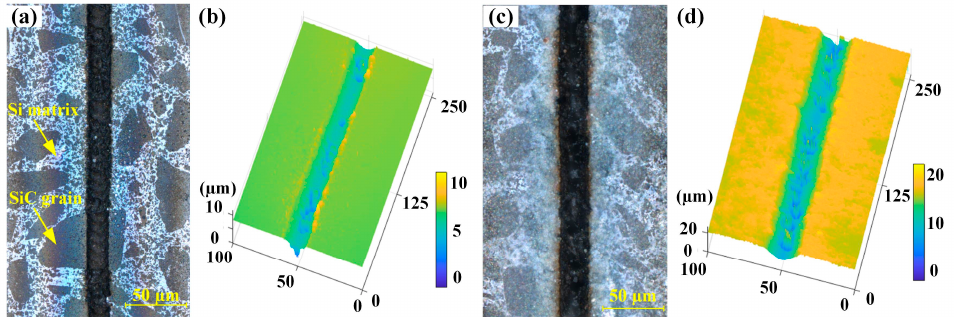
Figure 12. Microgroove morphology with laser energy of 10 µJ and scanning speed of 50 mm/s for the different number of passes: ( a ) 2D image and ( b ) 3D profile of a microgroove with 2 passes, and ( c ) 2D image and ( d ) 3D profile of a microgroove with 10 passes.